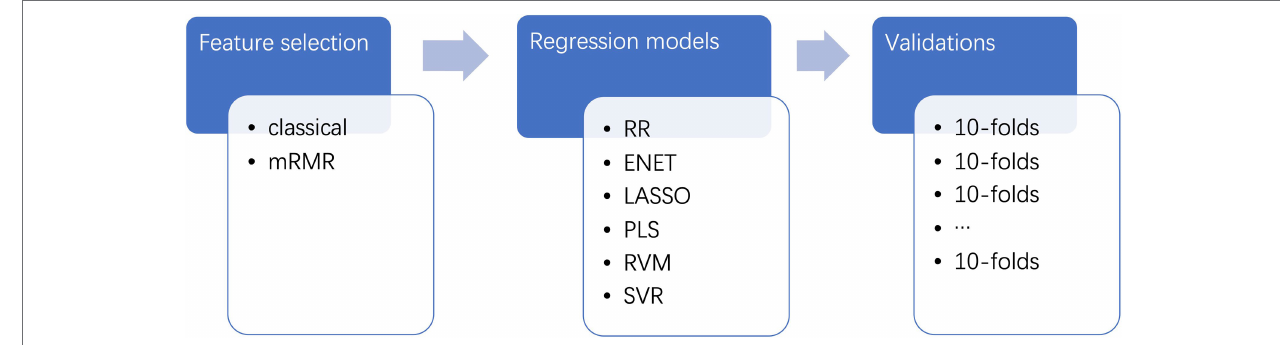
FIGURE 1 | Pipelines for the predictive models. The raw features of phase synchrony are firstly selected by two feature selection methods. Then, the selected features are trained and tested using several regression algorithms. Finally, the predictive models are validated using 100 runs of 10-fold cross-validations.